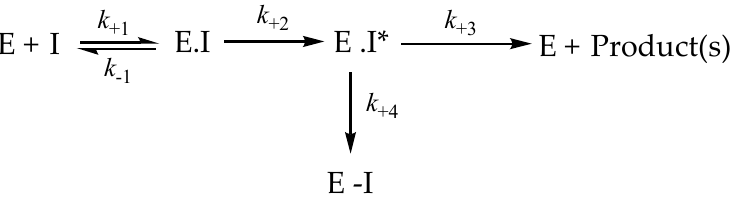
Scheme 1. General kinetic scheme for mechanism-based inactivation.